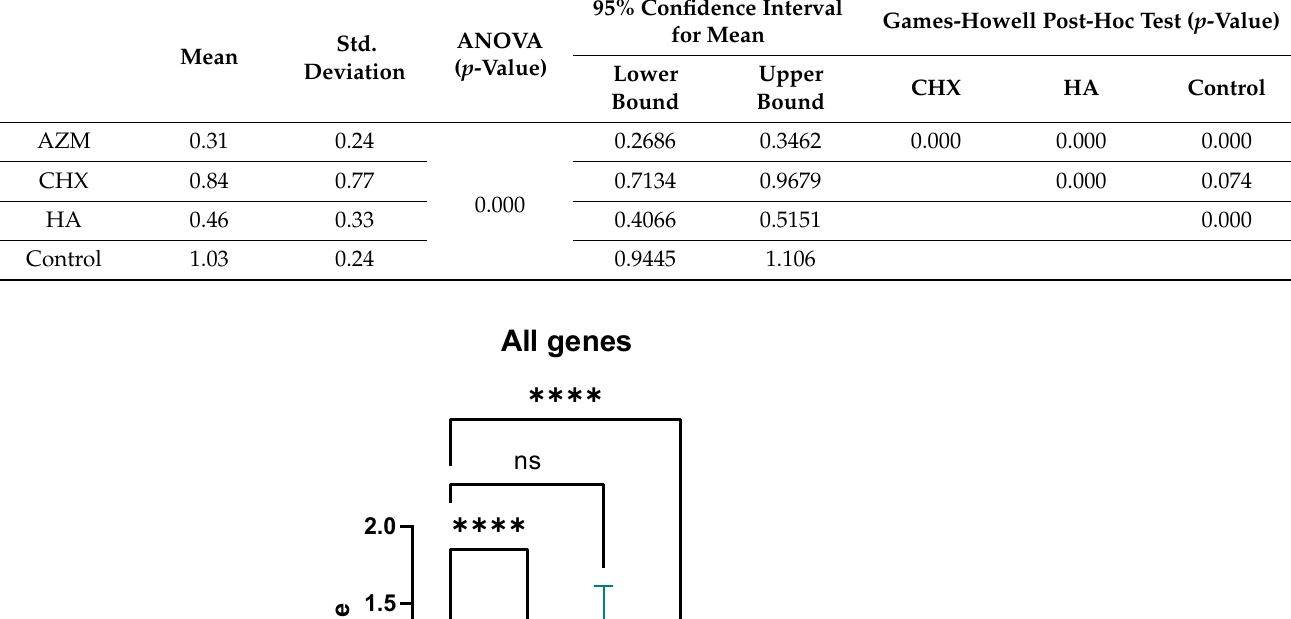
Table 2. Overall fold-change values for all genes combined.